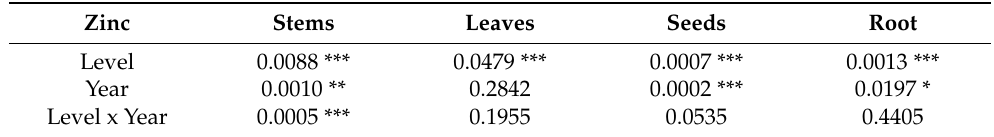
Figure 3. Concentration of Zn ( μ g g − 1 ) in the different fractions of the plant as average of two years. The multiple comparison between the means has been performed within the plant fractions. Values with different letters indicate statistical significance (according to HSD at p ≤ 0.05). Table 5. Two-way ANOVA of the main factor and interaction for zinc concentration in stems, leaves, seeds, and roots during the two years of the experiment (* significance level at p ≤ 0.05, ** significance level at p ≤ 0.005, *** significance level at p ≤